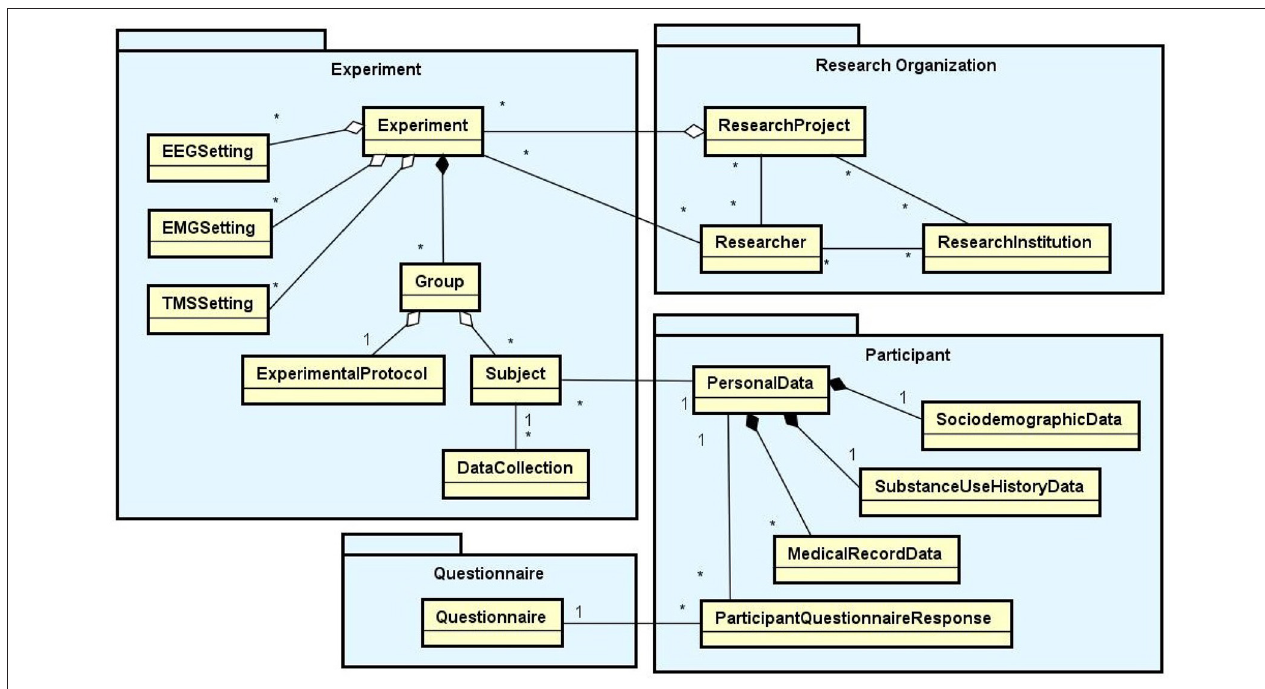
FIGURE 1 | Main data modules of NES ( Experiment , Research Organization , Participant , and Questionnaire ) with their entity types and relationships. In the diagram, the rectangles represent entity types, the lines ending with black diamonds represent composition relationships, the lines ending with white diamonds represent aggregation relationships, and the conventional lines represent association relationships. The “1” and “*” (that means “many”) near the lines indicate the cardinalities of the relationships. For example: a Group aggregates one ExperimentalProtocol and many Subjects ; an Experiment is composed of one or more Groups ; a Subject can have many DataCollections , but a DataCollection is associated with only one Subject